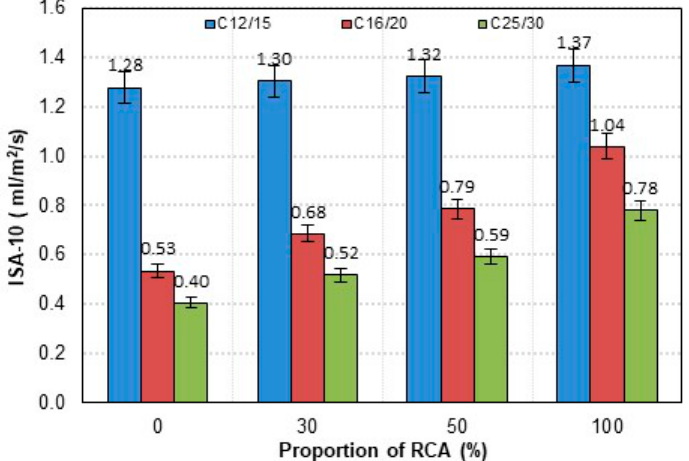
Figure 14. Effect of RCA proportions in the mix on the ISA ‐ 10 of concrete. Figure 14. E ff ect of RCA proportions in the mix on the ISA-10 of